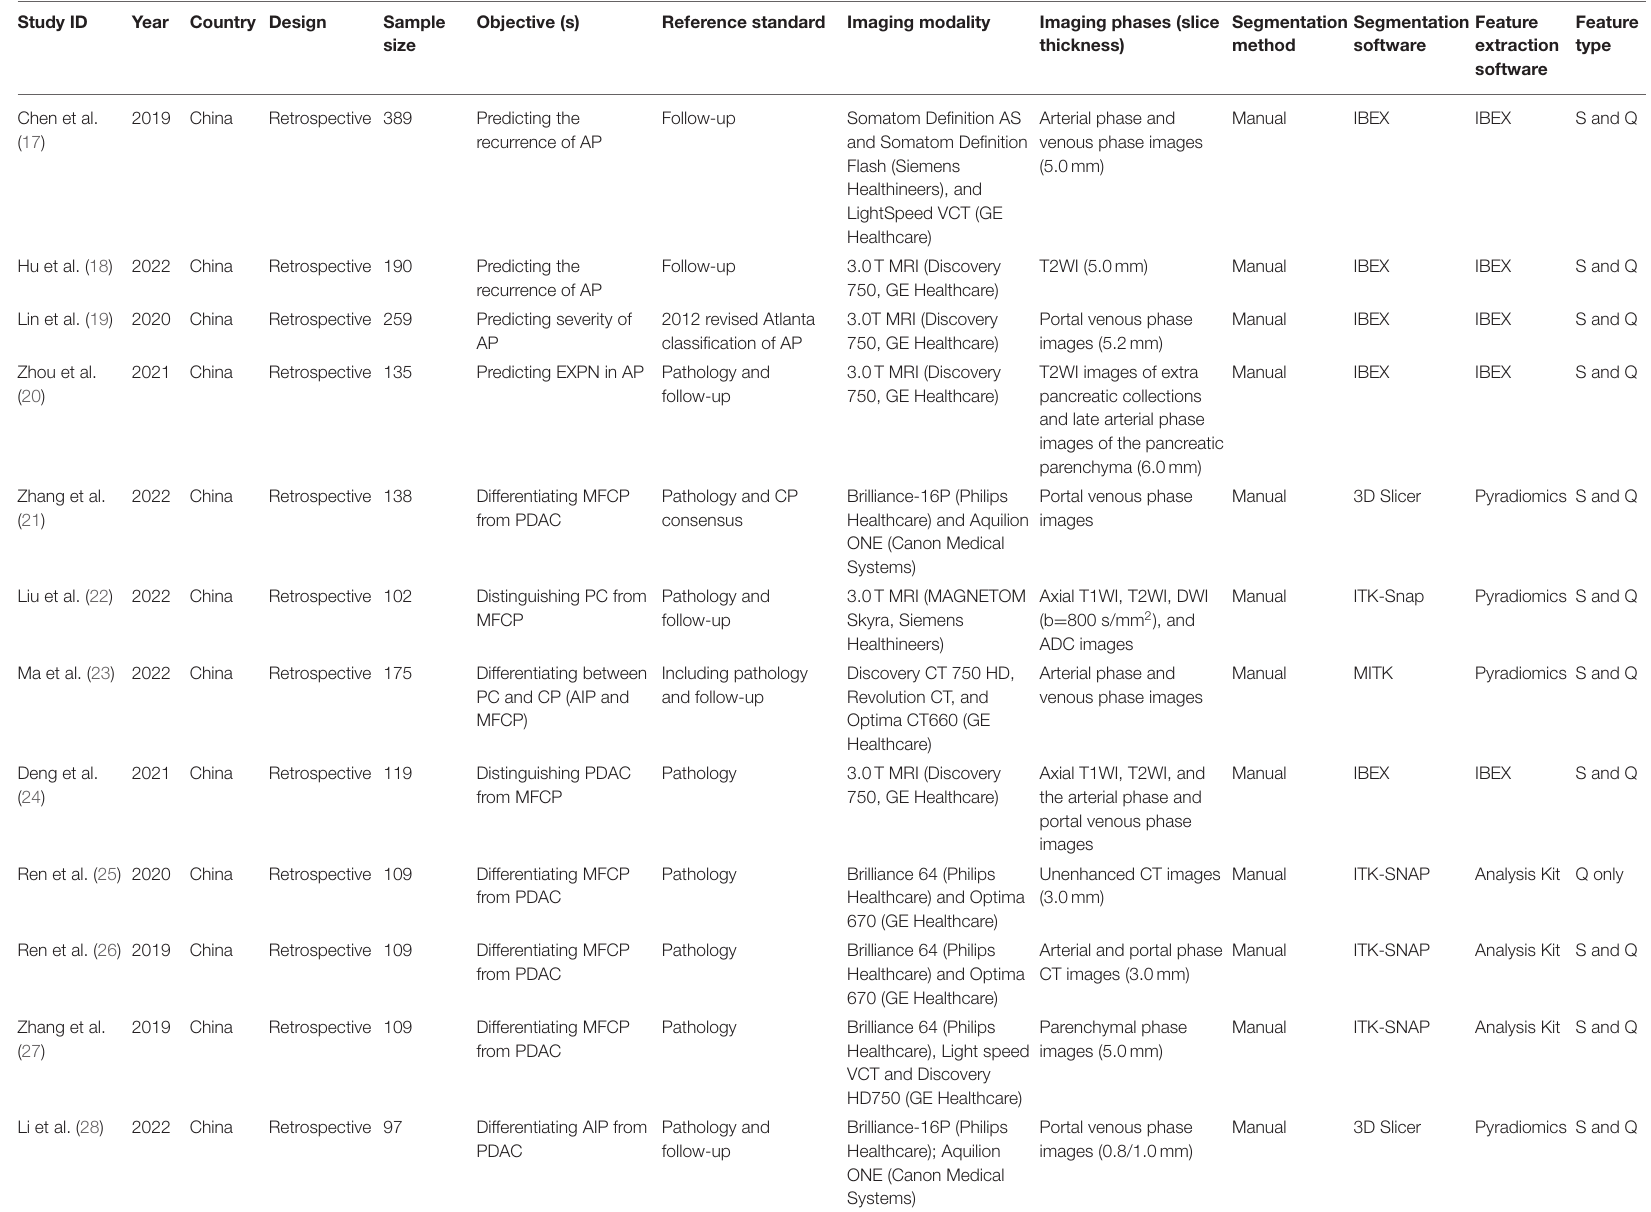
TABLE 1 | Characteristics of the included publications on radiomics in